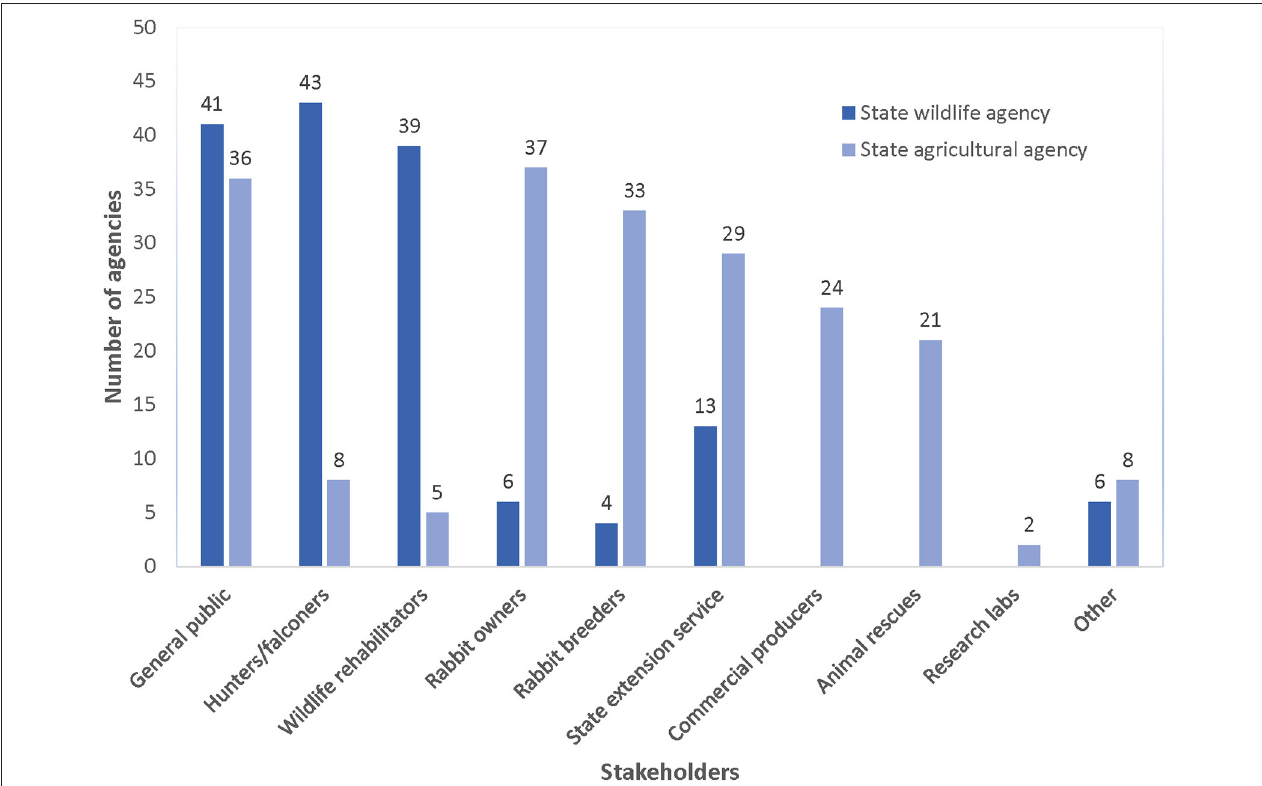
FIGURE 3 | Number of state agricultural ( n = 45) and wildlife agencies ( n = 50) that engage in education and outreach efforts targeted toward different stakeholder groups,